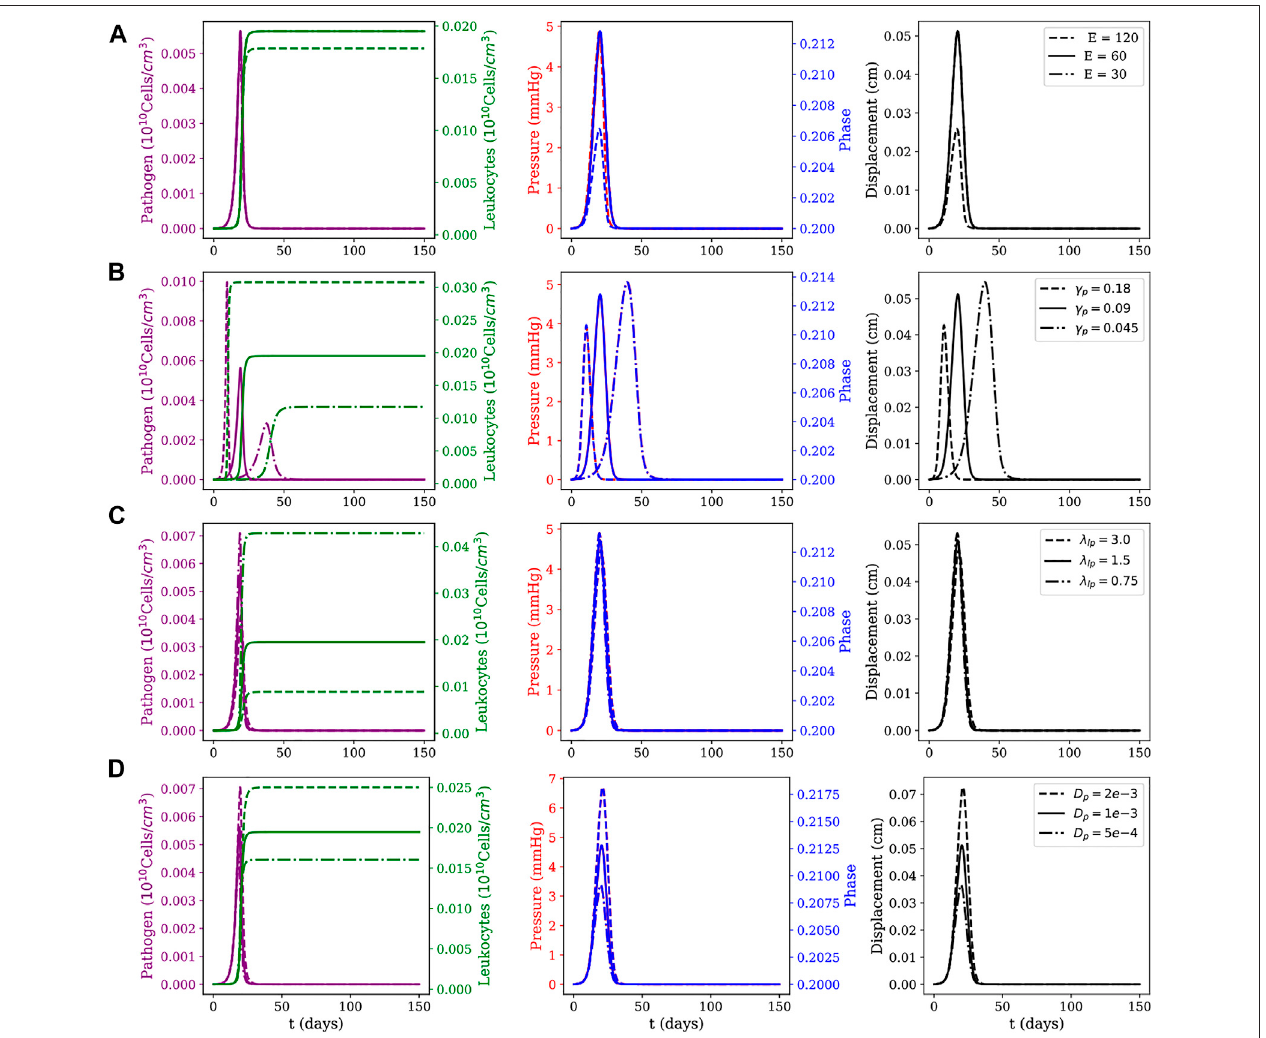
FIGURE 5 | Local myocarditis: evolution of pathogens and leukocytes concentration, pressure, fl uid phase, and displacement over 150 days of simulation for differentparametersets.Effectsofvariationson (A) Youngmodulus E (ascomputedfromtheLaméparametersfortheneo-Hookeanmodel), (B) pathogenreproduction rate γ p , (C) phagocytosisrate λ lp ; and (D) pathogens ’ diffusion coef fi cient d p . Foreach row, three scenarios forthe parameter under studyareconsidered:oneusing the reference value described in Table 1 , one using its value doubled and one using its value halved.